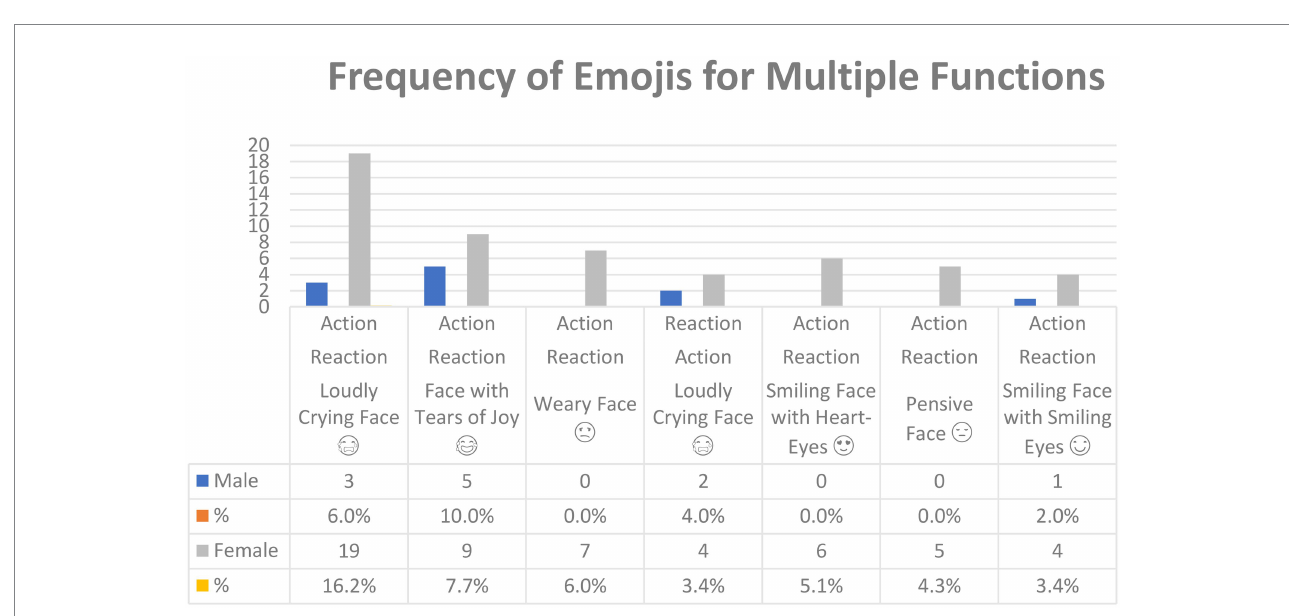
FIGURE 4 The most common emojis used for multiple functions in Arabic